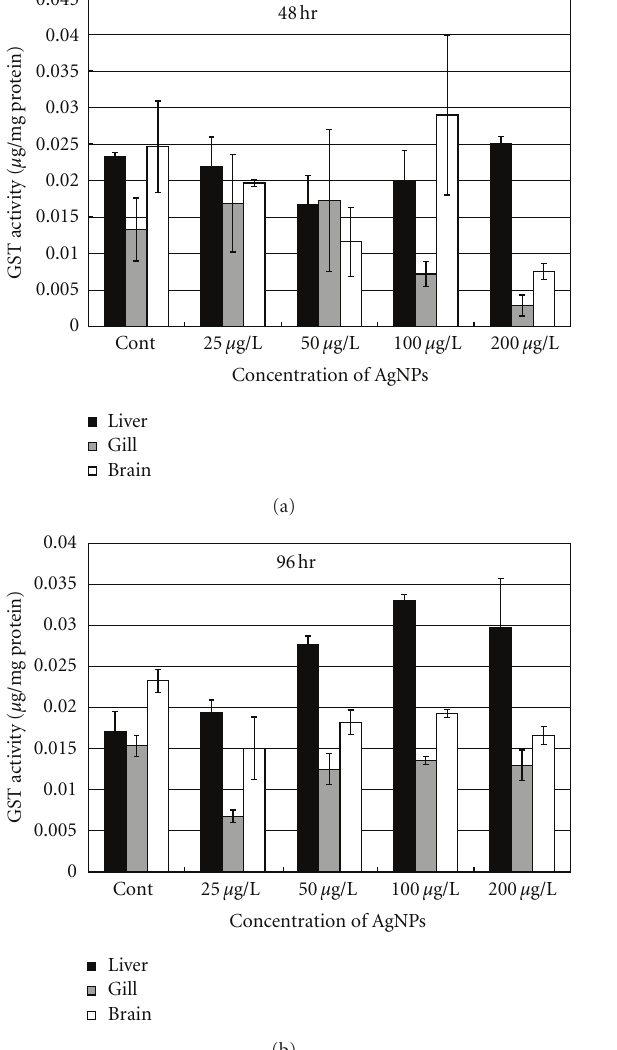
Figure 3: CAT activity in di ff erent organs of the common carp exposed to various concentrations of Ag-NPs at (a) 48 h and (b)